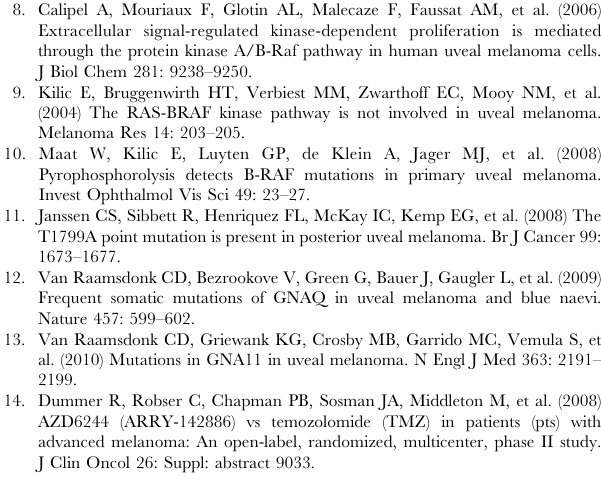
Figure S9 AZD8055/selumetinib induces apoptosis preferentially in BRAF mutant cutaneous melanomas. A panel of cutaneous melanoma cell lines of the indicated genotypes were treated with the indicated drugs for 72 hours (with the exception with MEL 267 which was treated for 48 hours) and then assayed by flow cytometry for DNA content in order to determine the percentage of cells with sub-G1 DNA, indicative of apoptosis. WT, defined as cells lacking BRAF, RAS, or any other known pathway mutations; N-RAS mutation , MEL 30 has a Q61K mutation and MEL 103 has a Q61R mutation in N-RAS; BRAF mutation , V600E. Table S1 List of the uveal melanoma cell lines utilized in this study. The gene mutations for each cell line listed were previously described/discovered by other groups. We also analyzed the cell lines on a mass spectrometry platform to assess for other hotspot gene mutations. Some of the relevant mutations tested include: AKT1 (E17K, R1114, Q1303, E1306*/K,